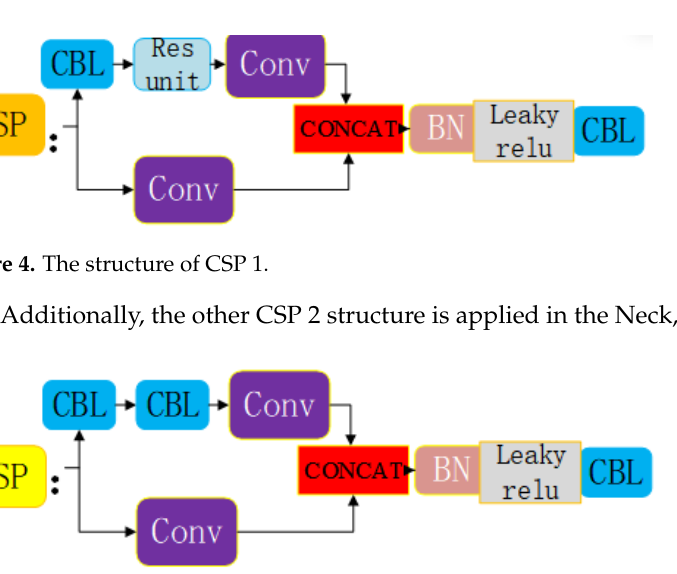
Figure 5. The structure of CSP 2.